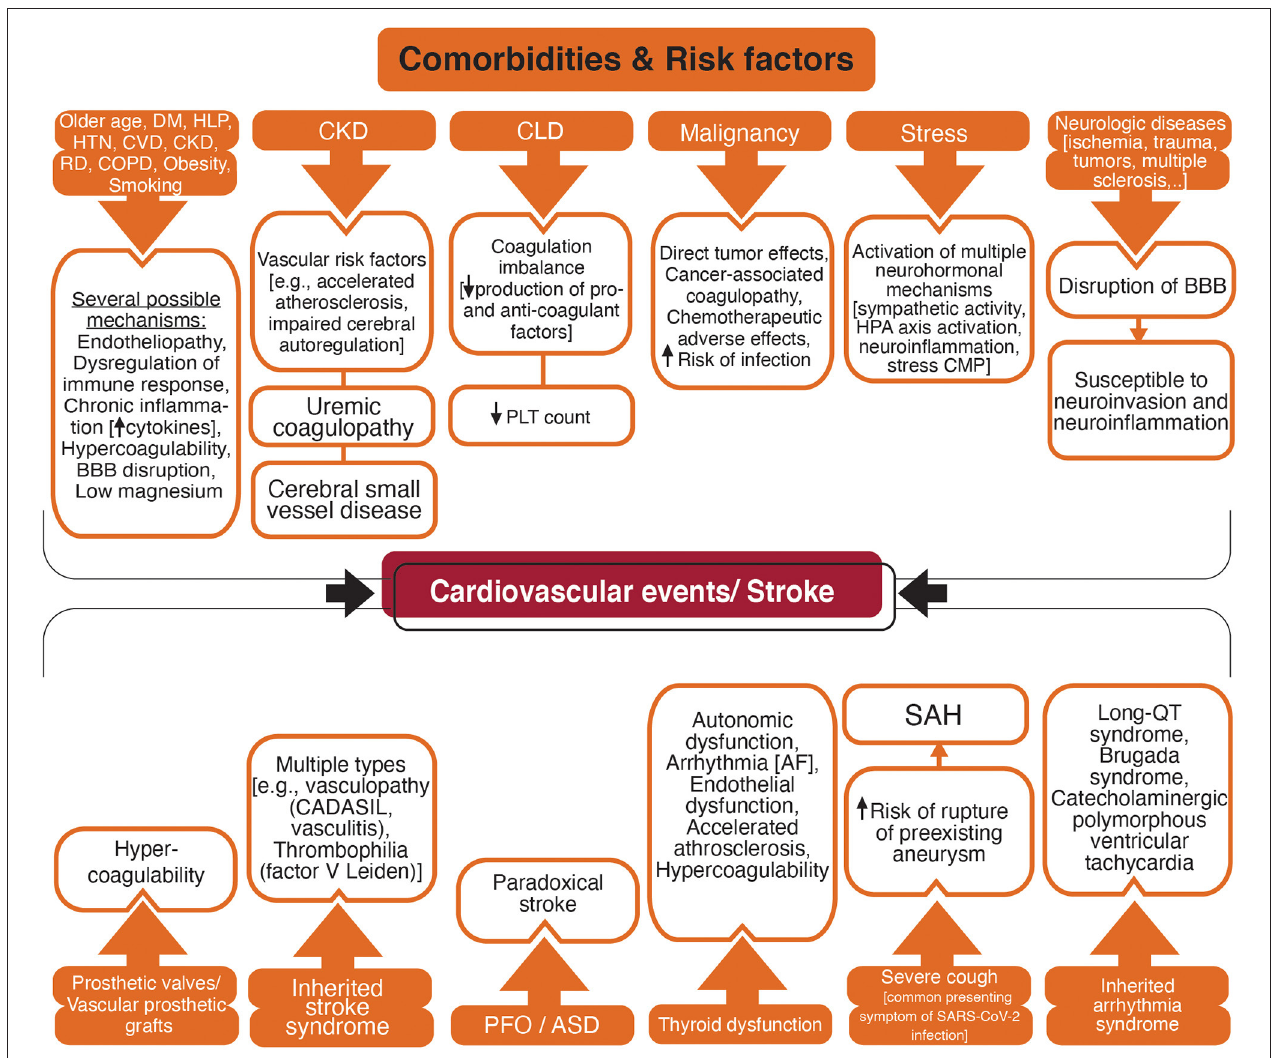
FIGURE 5 | Flowchart diagram shows acquired and inherited factors with a higher risk for vascular events and possible associated mechanisms. DM, Diabetes mellitus; HLP, Hyperlipidemia; HTN, Hypertension; CVD, Cardiovascular disease; CKD, Chronic Kidney disease; RD, Rheumatic disease; COPD, Chronic obstructive respiratory disease; BBB, blood-brain barrier; CLD, Chronic Liver Disease; PLT, Platelet; HPA, Hypothalamic-pituitary-adrenal; CMP, Cardiomyopathy; CADASIL, Cerebral autosomal dominant arteriopathy with subcortical infarcts and leukoencephalopathy; PFO, Patent foramen ovale; ASD, Atrial septal defect; AF, Atrial fibrillation; SAH, Subarachnoid hemorrhage; SARS-CoV-2, Severe acute respiratory syndrome coronavirus